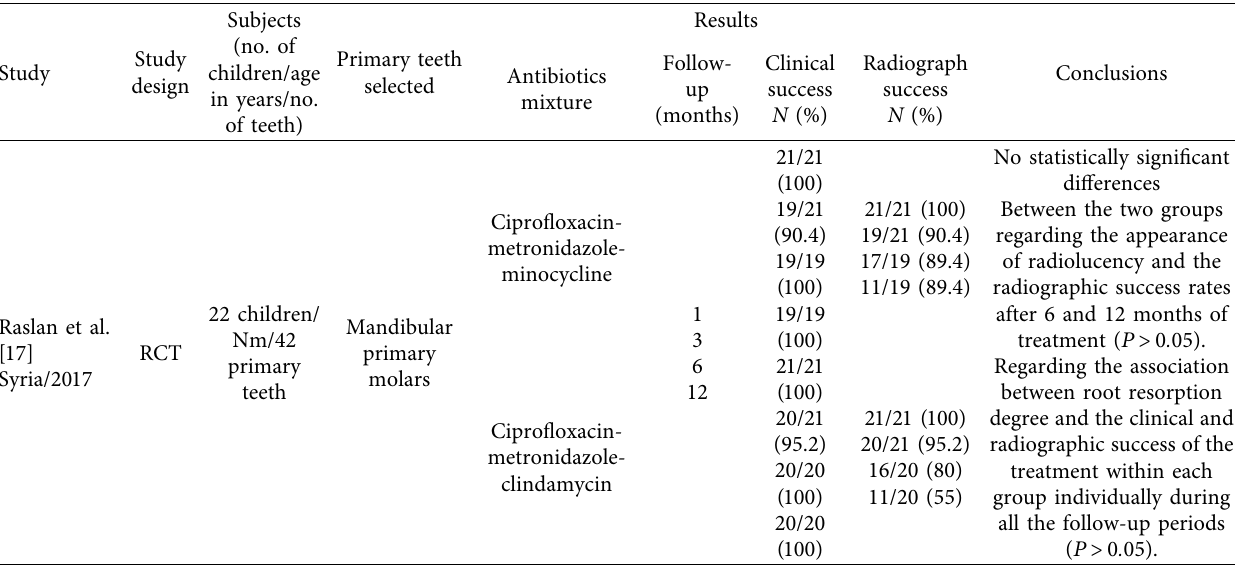
Comparison 3: 3 Mix versus ciprofloxacin-metroni- dazole-clindamycin